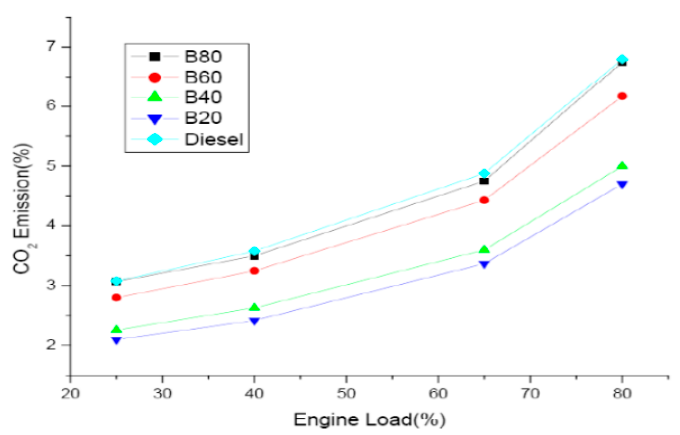
Figure 8. Effect of biodiesel and engine load on CO 2 emissions [49].